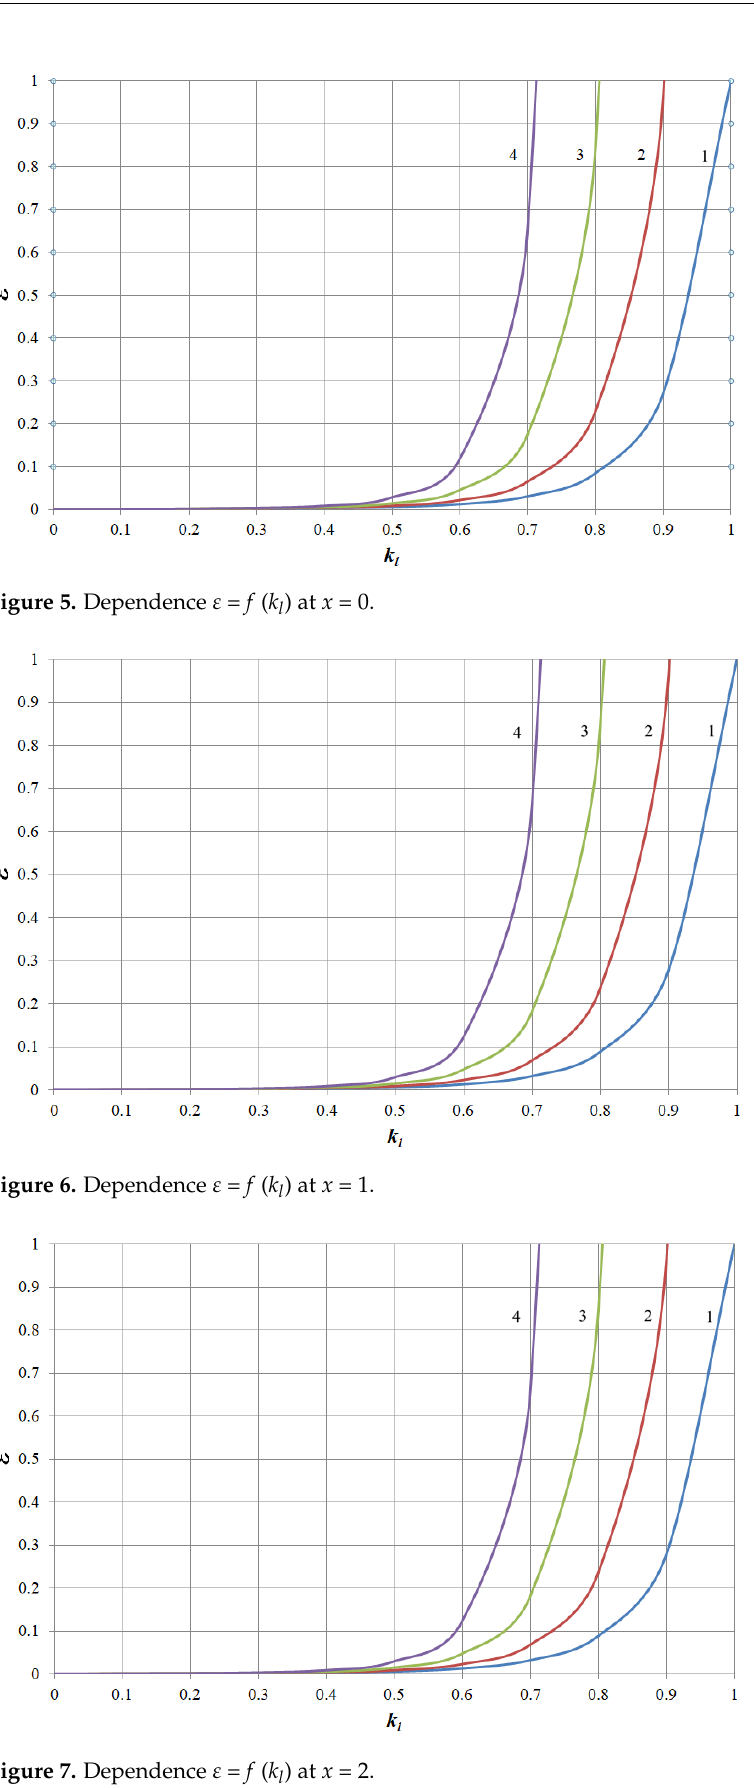
Figure 8. Dependence ε = f ( k l ) at х = − 1. As can be seen from Figures 5–8, the dependences are of the same type, which is determined by the exponential dependence of the rate of thermal wear of insulation shown in (1). However, the numerical values of the rate of thermal wear of insulation with the same electric motor driving working machines with different mechanical characteris- tics differ when the voltage is reduced. This can be seen from the results shown in Tables 1–4. The tables show examples of the dependence ε = f ( k l ) at k u = 0.9 for AIR132S4 induction motor driving working machines with different types of mechanical characteristics.